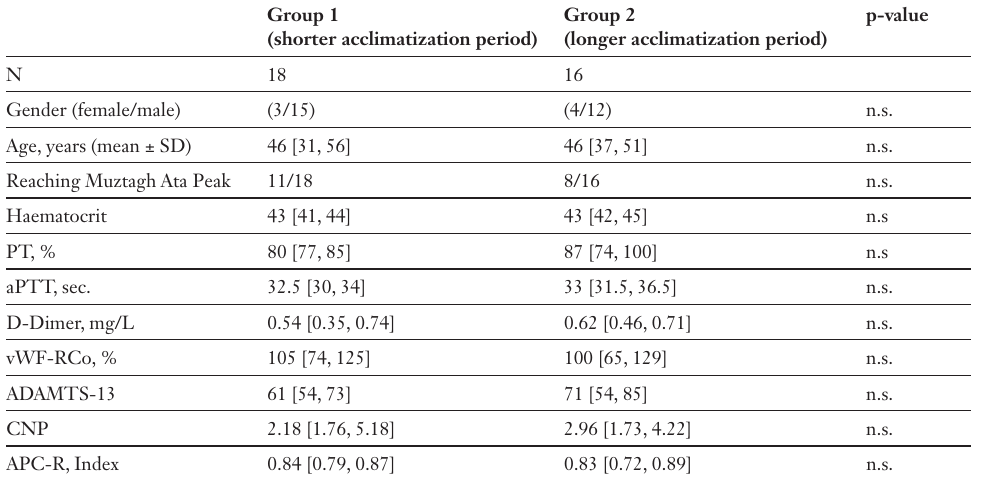
Course of coagula- tion parameters during high altitude expedition.